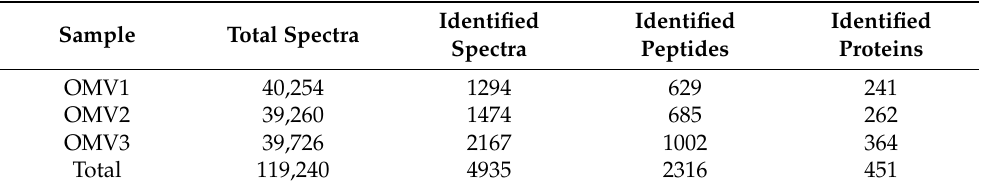
Table 1. Mass spectrometry and Mascot comparison data of Pbr1692